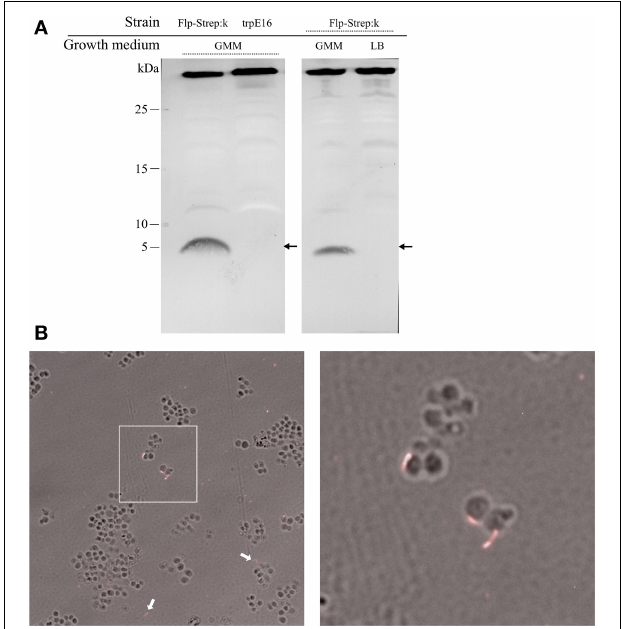
FIGURE 3 | Western blot analysis and visualization of competence-related pili in M. luteus by immunofluorescence microscopy. (A) Alkaline phosphatase-conjugated Strep -Tactin Western blot of extracellular sheared fractions of the strain carrying an affinity-tagged version of the Flp prepilin (Flp-Strep:k) and the wild type srtain (trpE16), grown under competence-inducing conditions (left panel). Extracellular sheared fractions of the Flp-Strep:k strain grown in minimal (GMM) and in rich (LB) medium, showing production of Flp-Strep pilin only under competence-inducing conditions (right panel). The predicted size of the Flp-Strep fusion is 5.6kDa (arrows). The band around 35kDa, originating from an unknown biotinilated M. luteus protein, was included to demonstrate equal amount of proteins in the samples. (B) Immunofluorescence microscopy of the Flp-Strep:k strain, grown to competence state, using an Oyster 556-labeled anti- Strep -tag antibody. Shown are overlays of fluorescence and phase contrast images. The white arrows show cell-unassociated pili. The right panel is a magnification of the white square area of the left